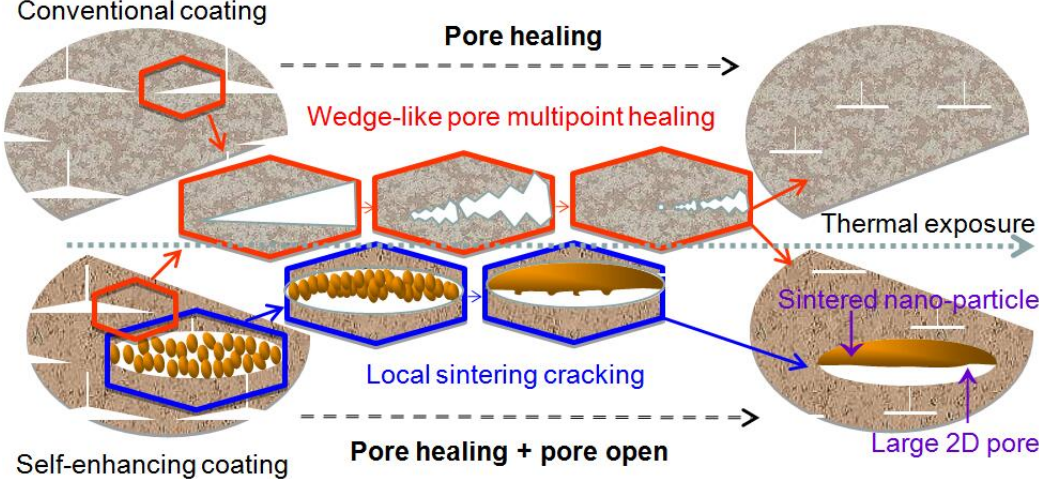
Fig. 65 Schematic diagram of sintering mechanisms of the conventional and self-enhancing coatings undergoing thermal exposure. Reproduced with permission from Ref. [383], © The Nonferrous Metals Society of China and Springer-Verlag GmbH Germany, part of Springer Nature